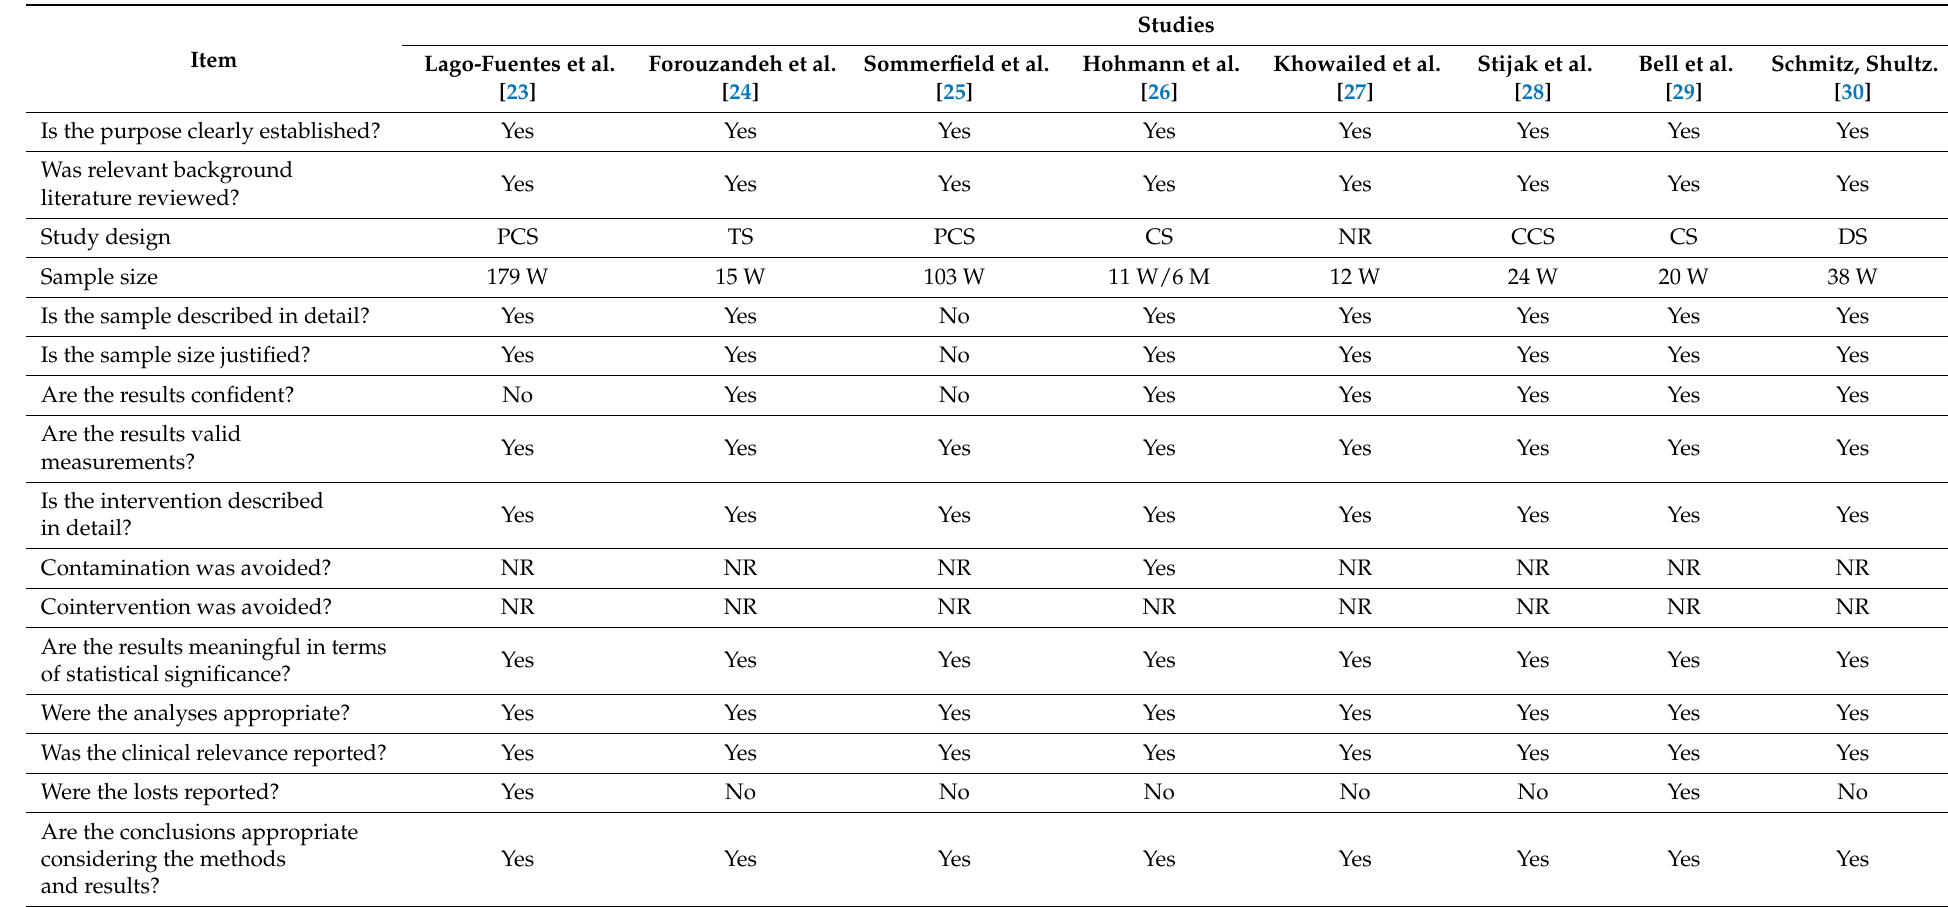
Table 1. Methodological quality of the studies